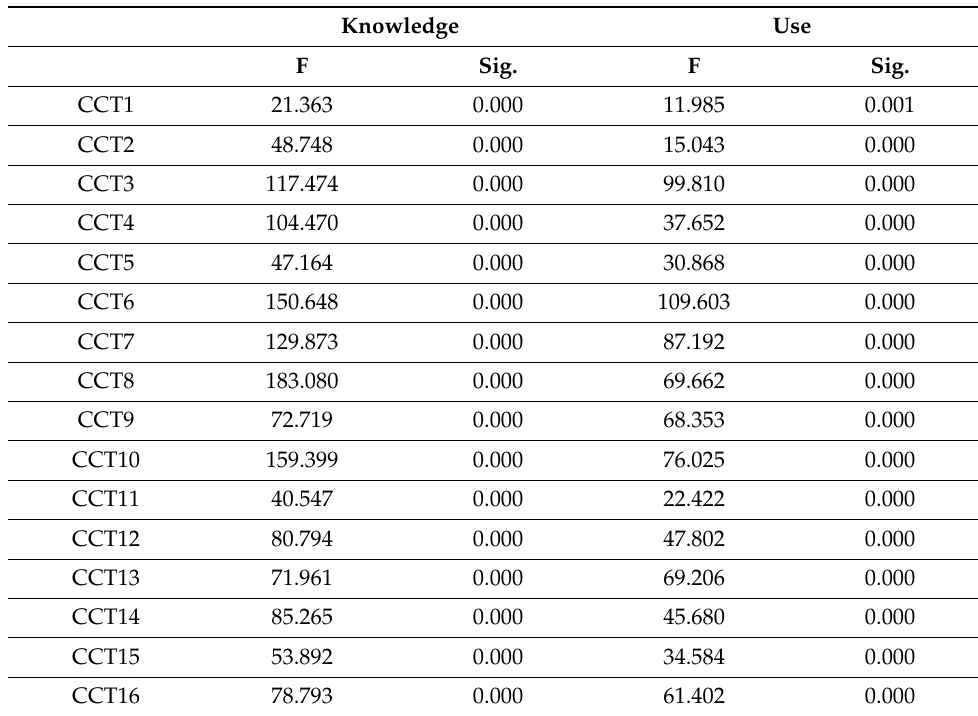
Table A14. ANOVA: knowledge and use of content creation tools.